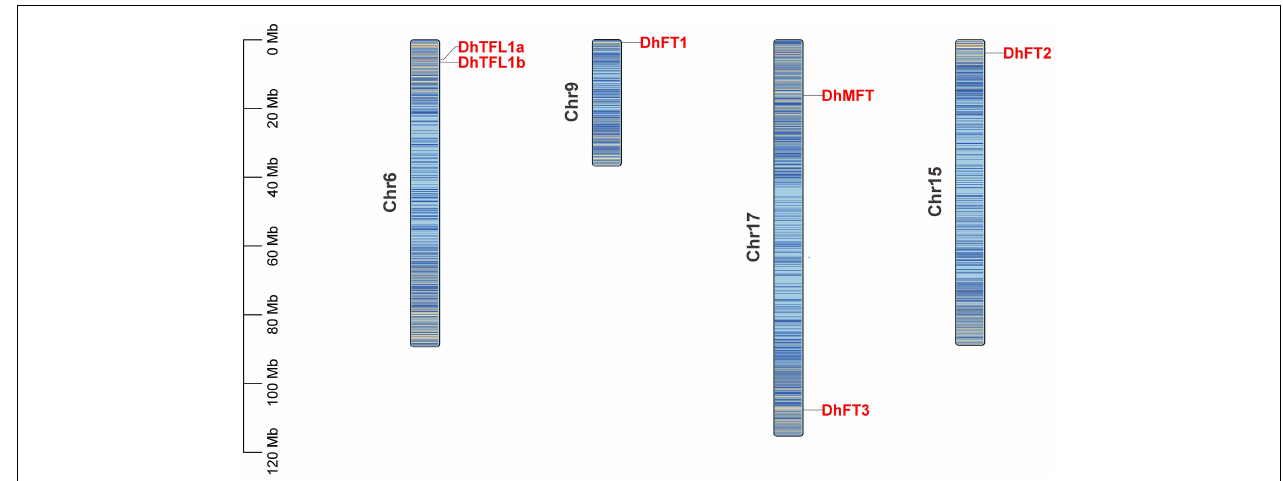
FIGURE 2 | The chromosome location of PEBP genes of D.